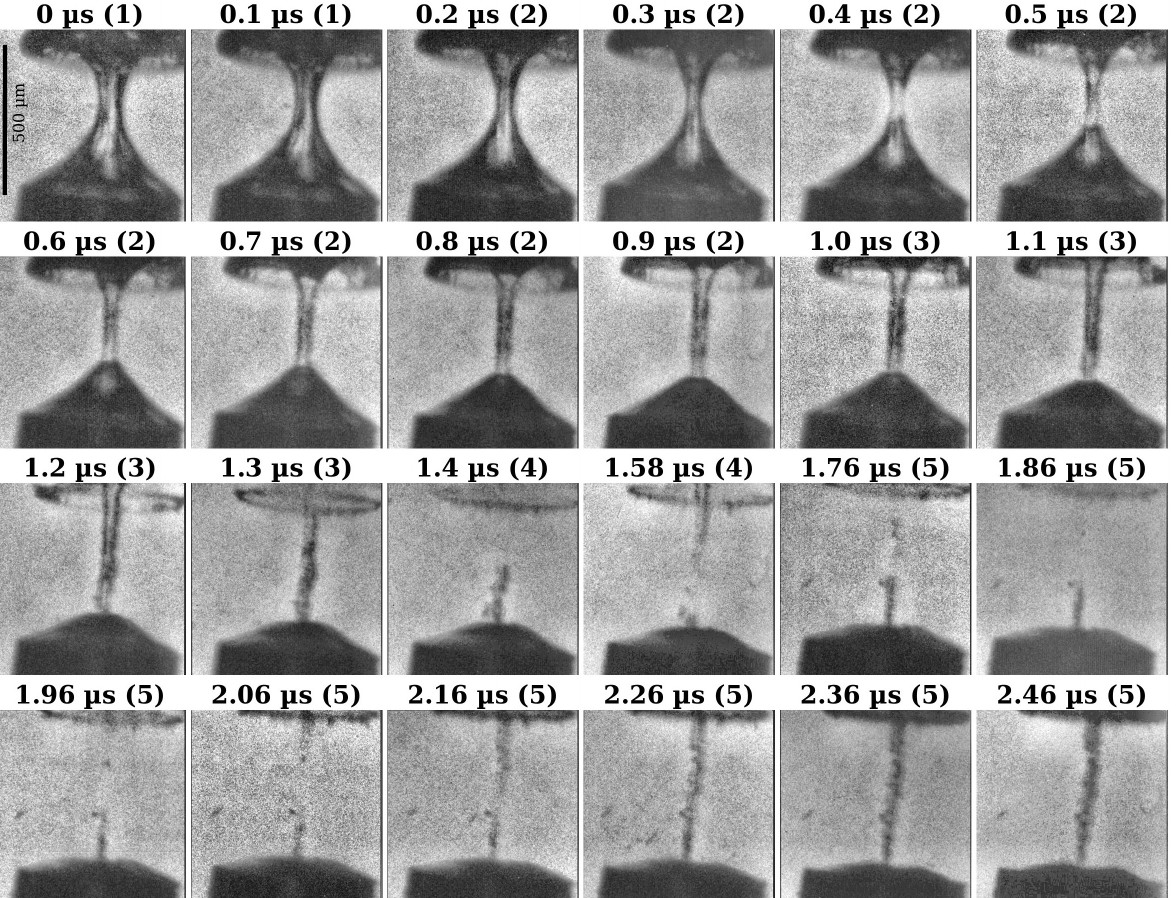
Figure 8. Neck and stem dynamics of a mushroom-shaped bubble for D ∗ ≈ 0, r p = 272.8µm. Experimental images of a bubble similar to Figures 4 and 5, but with ultra-high-speed frame rate (10,000,000fps and 5,555,556fps). Exposure time is 30ns. Five recordings are stacked together (recording number in parentheses). Frame width is 633.5µm ±